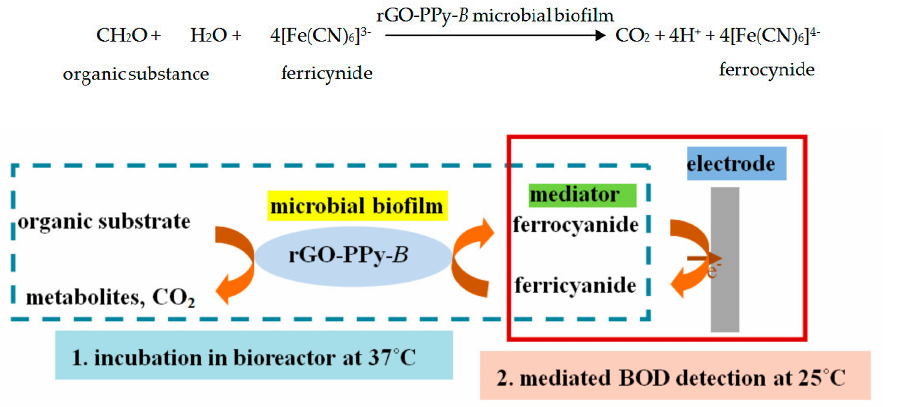
Figure 2. Schematic detection mechanism of the mediated biochemical oxygen demand (BOD)